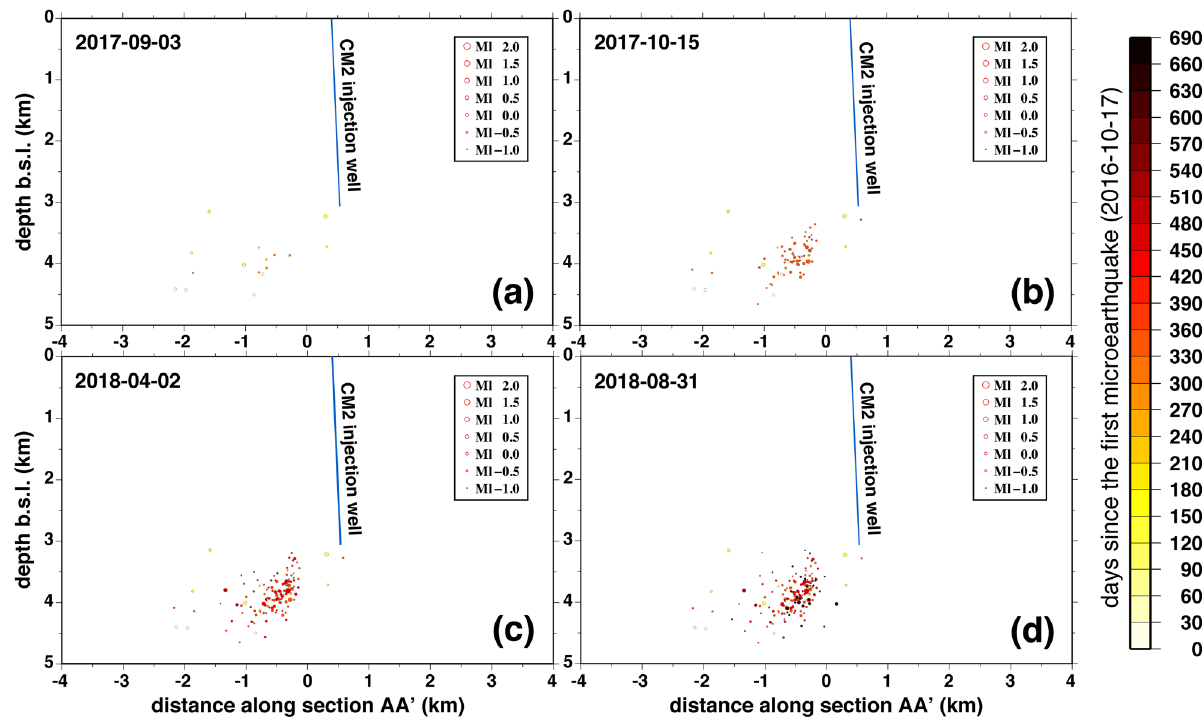
Figure 4. Projection of microearthquake hypocenters (only events relocated with double-difference method) along the vertical cross section of the AA ′ profile displayed in Fig. 1 in four different time periods: ( a ) until 2017-09-03; ( b ) from 2017-09-17 to 2017-10-15; ( c ) from 2017-12-31 to 2018-04-02; ( d ) from 2018-04-14 to 2018-08-31. The dimension of the circles is proportional to the local magnitude of the seismic events whereas the color of the circles indicates the earthquake origin time expressed in days since the first event. The blue line in each panel represents the projection of the CM2 injection well along the AA ′ vertical cross